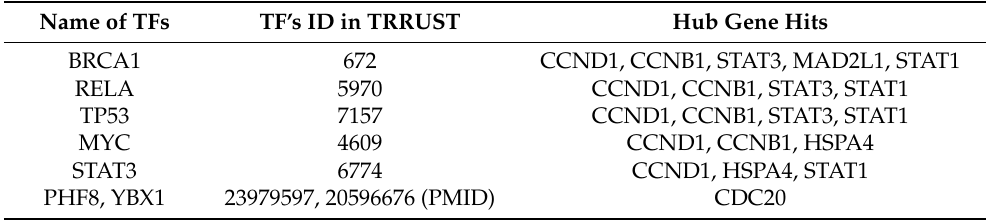
Table 7. TFs that govern the hub